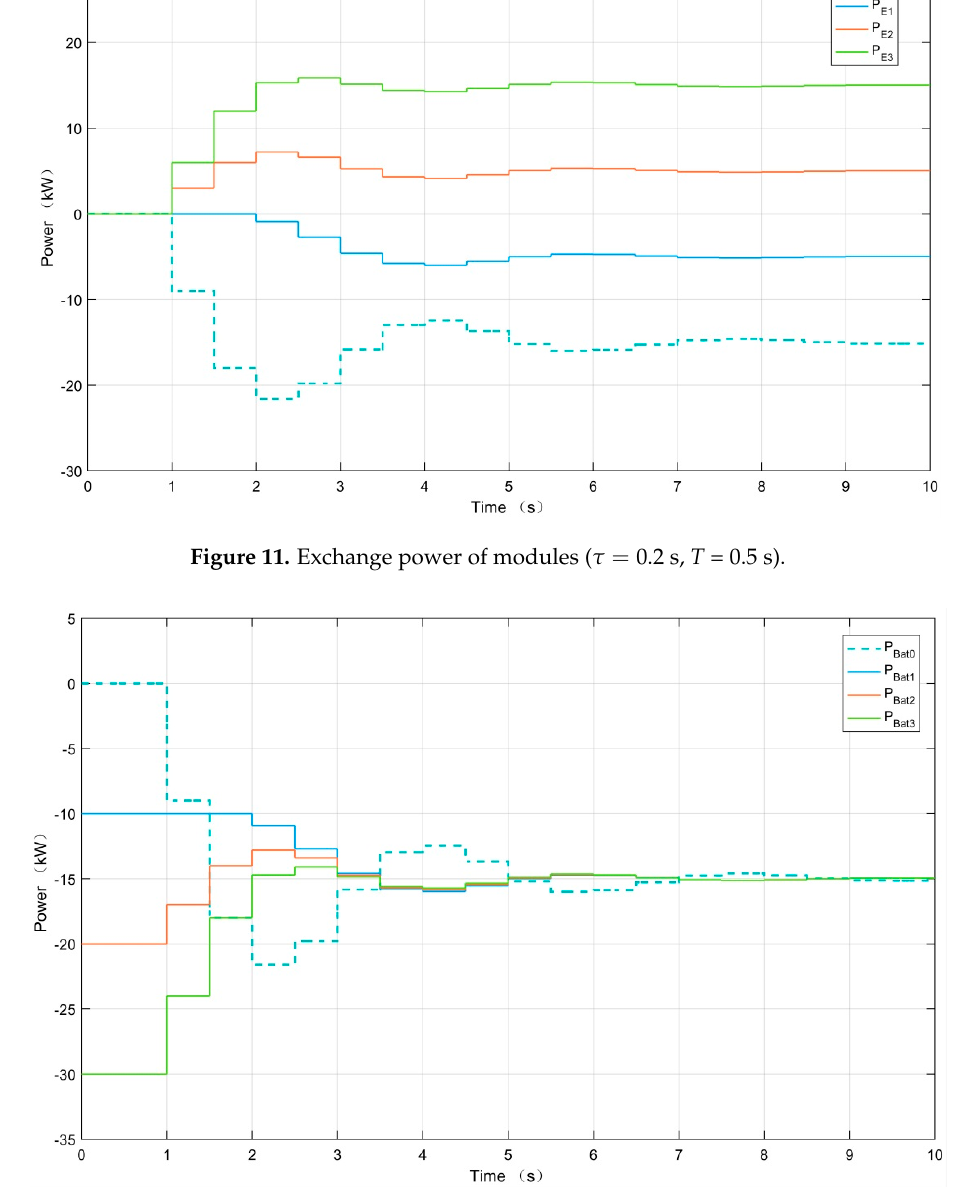
Figure 12. Battery power in modules ( (cid:2028) = 0.2 s , T = 0.5 s).